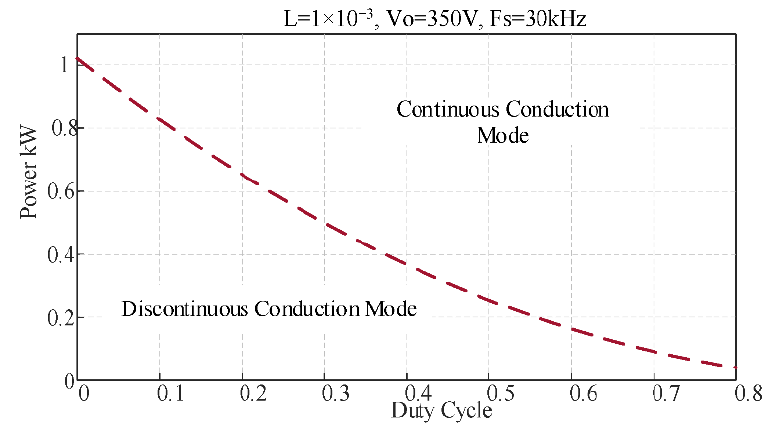
Figure 6. CCM and DC boundary.